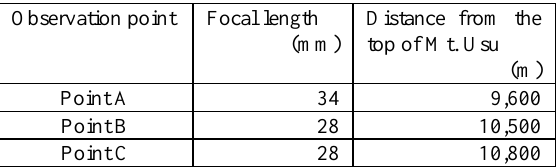
Table 1. Focal length and distance of